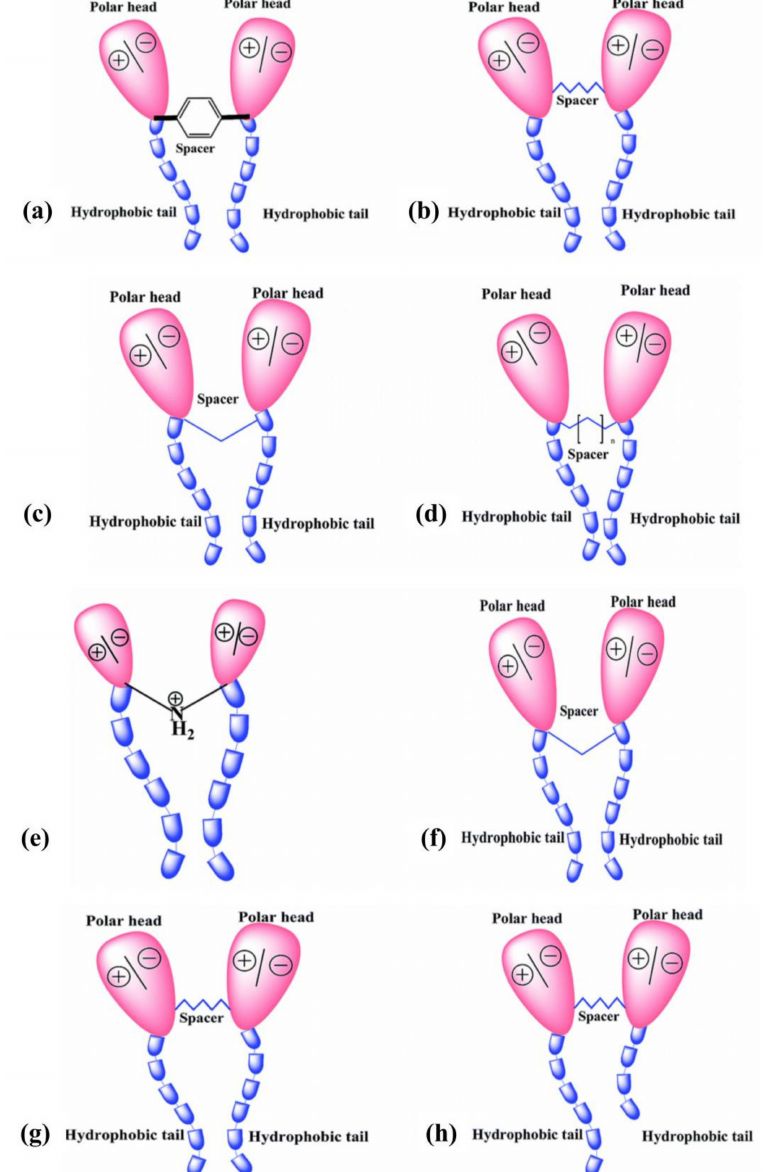
Figure 9. Simplified schematic representation of the physical structure of gemini surfactant: ( a , b ) are gemini surfactants with rigid and flexible spacers, ( c , d ) are gemini surfactants with short chain and long chain spacers, ( e , f ) are gemini surfactants with polar and nonpolar spacers, and ( g , h ) are gemini surfactants with two identical and nonidentical hydrophobic chains. (Reprinted with permission from Ref. [203]. Copyright 2015 Royal Society of Chemistry